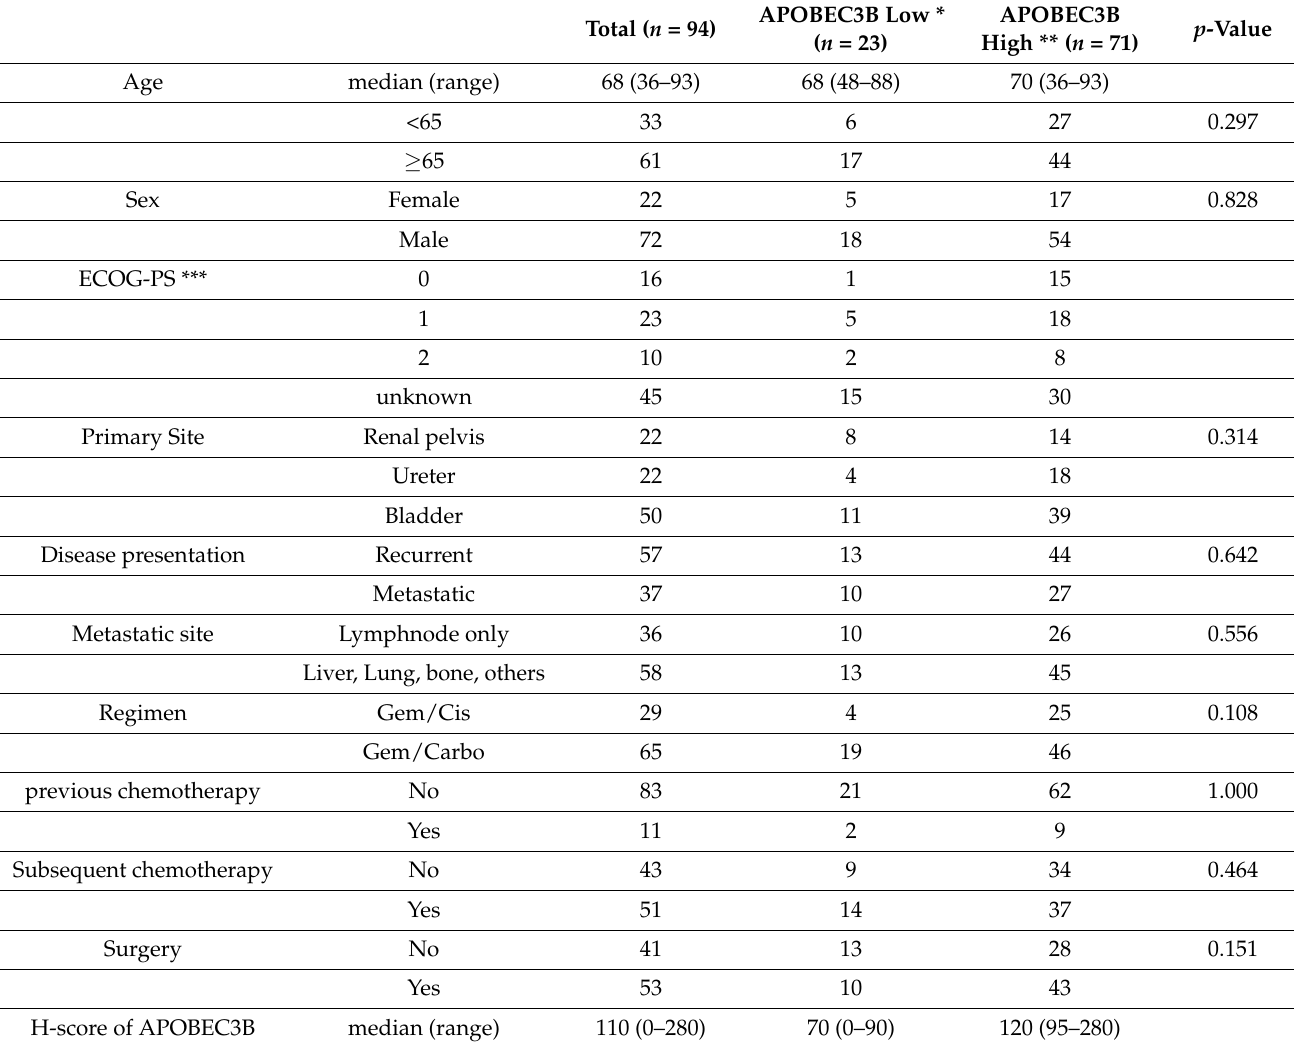
Table 1. Baseline characteristics of the